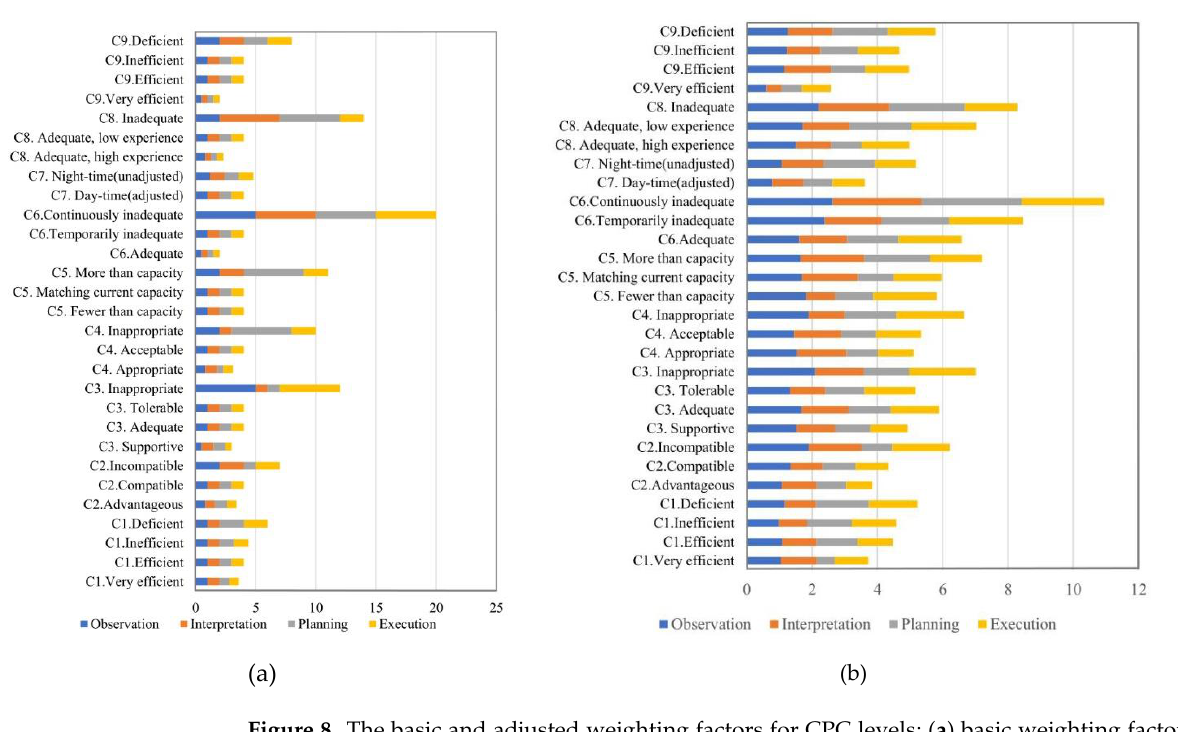
Figure 8. The basic and adjusted weighting factors for CPC levels; ( a ) basic weighting factors for CPC levels; ( b ) adjusted weighting factors for CPC levels.